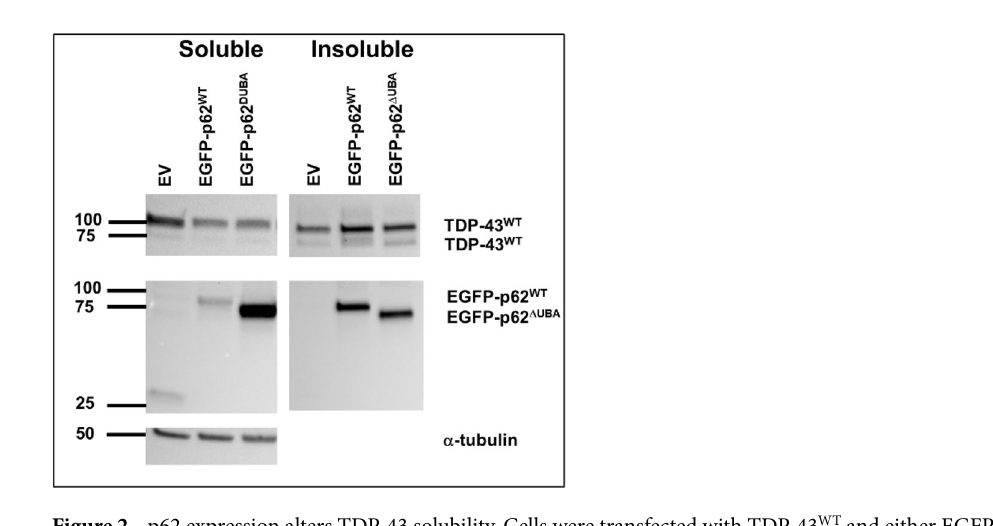
Figure 2. p62 expression alters TDP-43 solubility. Cells were transfected with TDP-43 WT and either EGFP, EGFP-p62 WT or EGFP-p62 ΔUBA (as indicated), and 48 h post-transfection cells were lysed in Triton-X buffer (soluble). Triton-X insoluble pellets were solubilized with SDS (insoluble). Western blot analyses with GFP, RFP and α-tubulin antibodies were performed. Image is representative of 3 independent